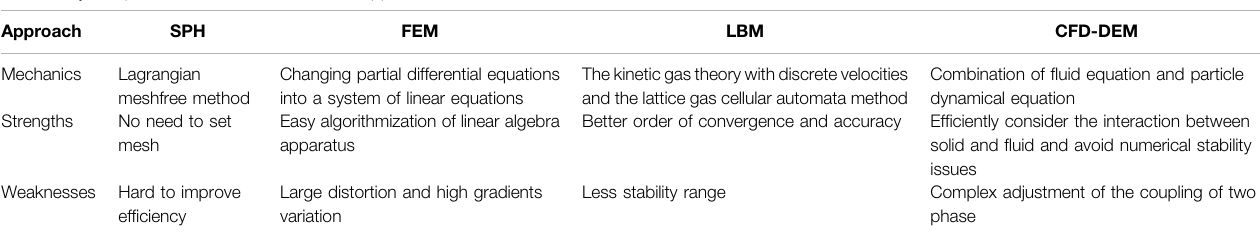
TABLE 3 | Comparison of numerical simulation